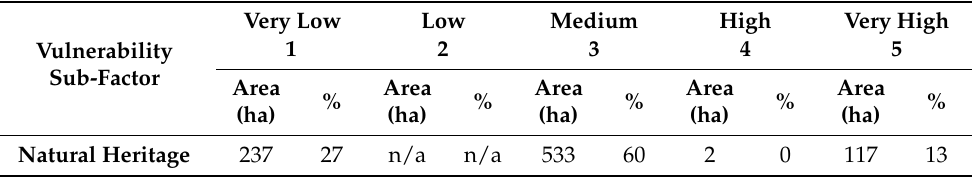
Table 31. Areas and percentages of the study area classified as each class of the natural heritage vulnerability sub-factor.